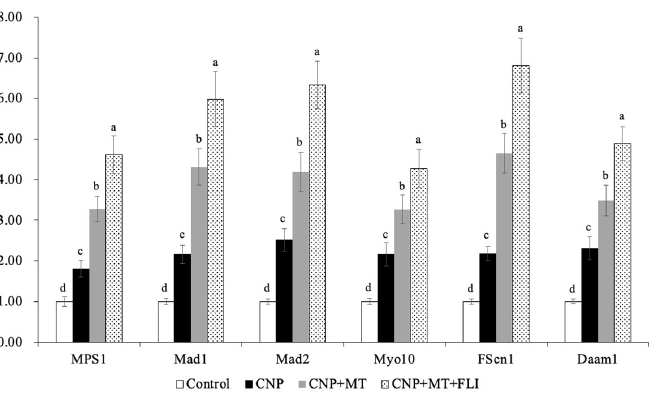
Figure 6. Effect of the combination treatment CNP, MT, and FLI on the gene expression in bovine oocytes. a, b, c, d Values with different superscripts indicate significant differences between groups ( p <